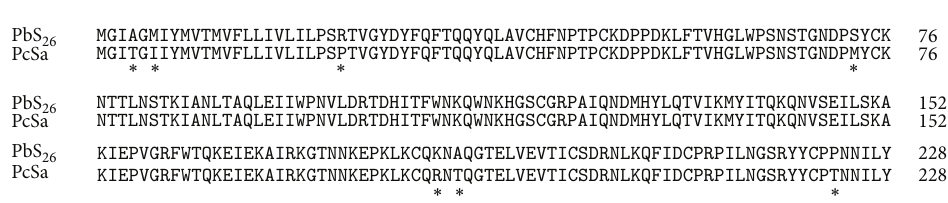
Figure 2: Alignment of amino acid sequences of the PbS